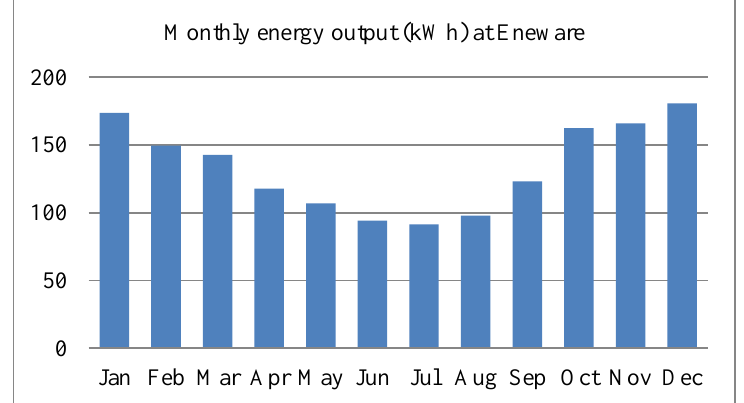
Figure 7. Energy assessment of solar system at Mehal Meda.